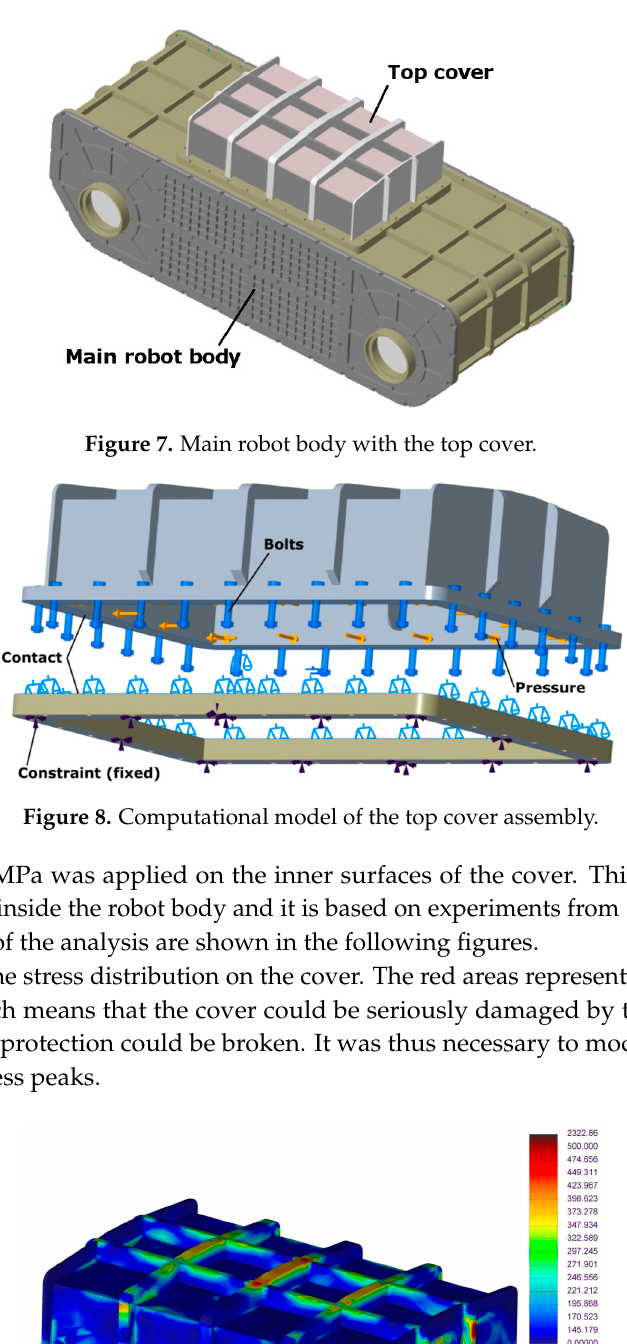
Figure 9. Stress distribution during an explosion simulation (initial design).